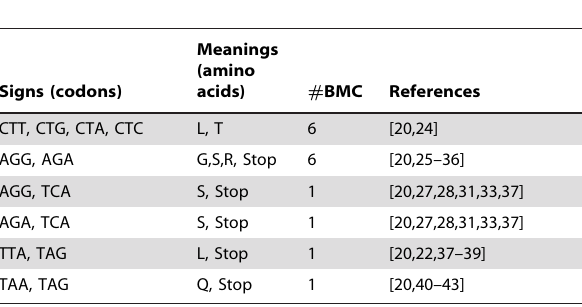
Table 2. Molecular codes in the reaction network model of the 17 known genetic